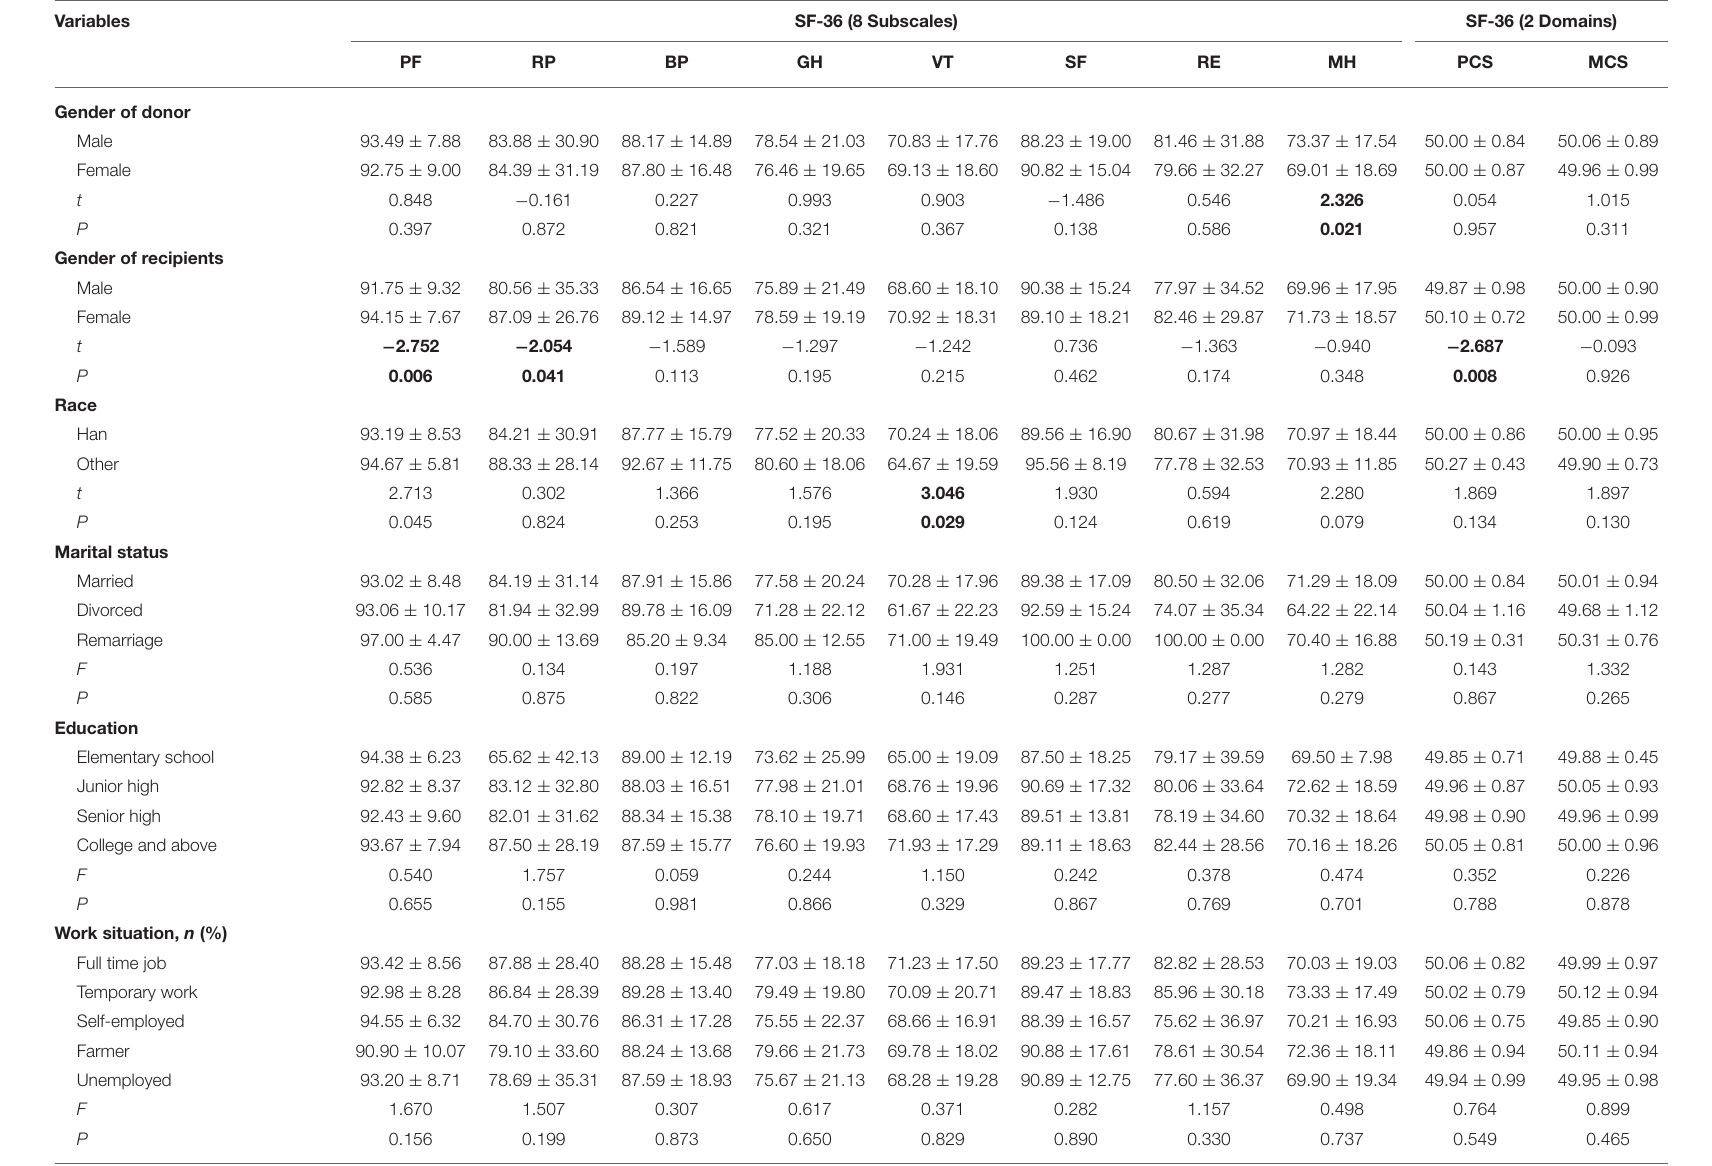
TABLE 4 | The score of each subscale and two summary domains in SF-S6 for different demographic groups.